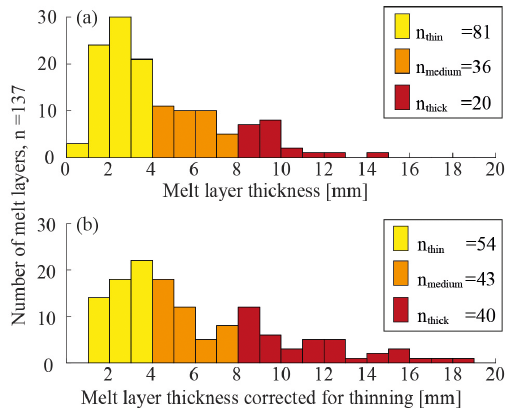
Figure A3. Histogram of melt layer thicknesses; the same color code is used as in Fig. 7. (a) Measured values and (b) values cor- rected for thinning using the thinning function from Gerber et al.